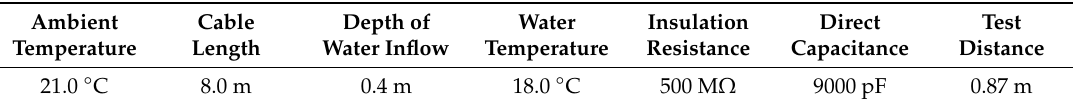
Table 2. The test environment of the